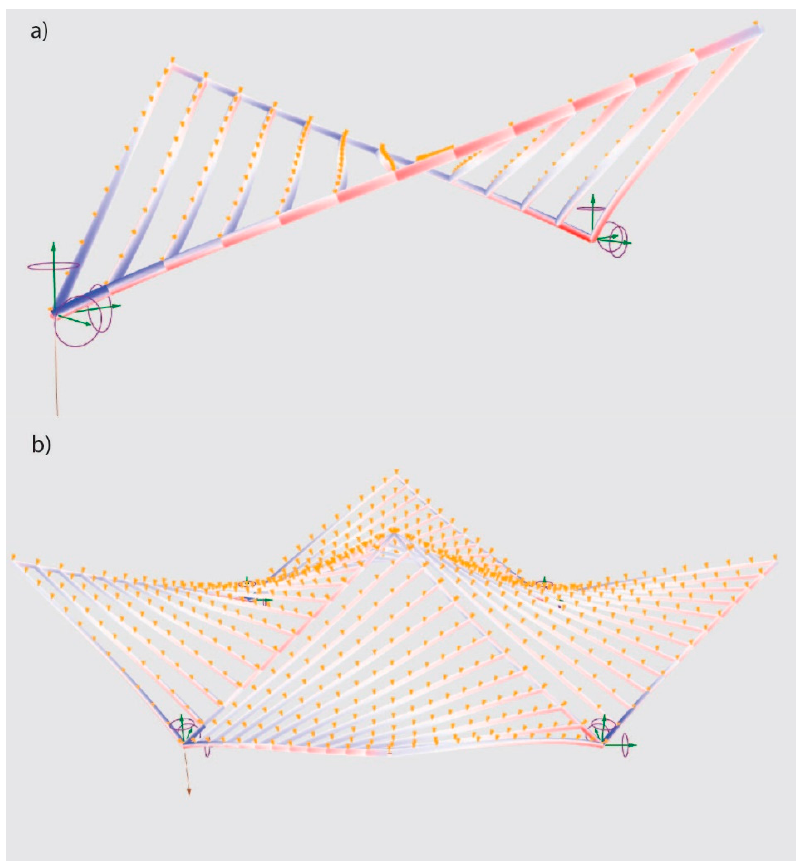
Figure 3. ( a ) One module of double curvature shell simulated in Karamba3D; ( b ) Four modules double curvature shell simulated in Karamba3D. double curvature shell simulated in